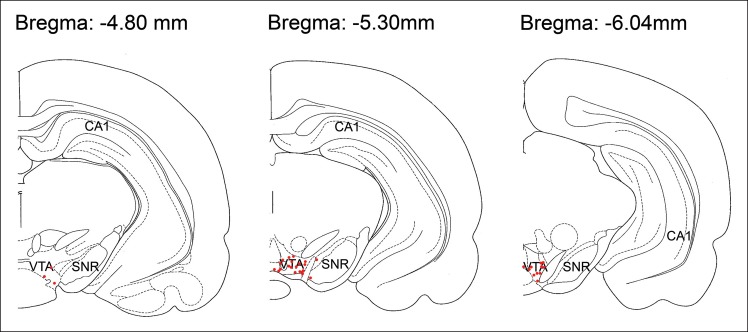
Histological location of tetrode tips targeting the VTA.For each rat, electrolytic lesions marked the tetrode tip locations, and these were mapped onto the stereotaxic atlas of Paxinos and Watson (1998). Tetrode tips under-represent recording locations, which were acquired as electrodes were systematically lowered within the VTA along their tracks. SNR, substantia nigra reticulata.